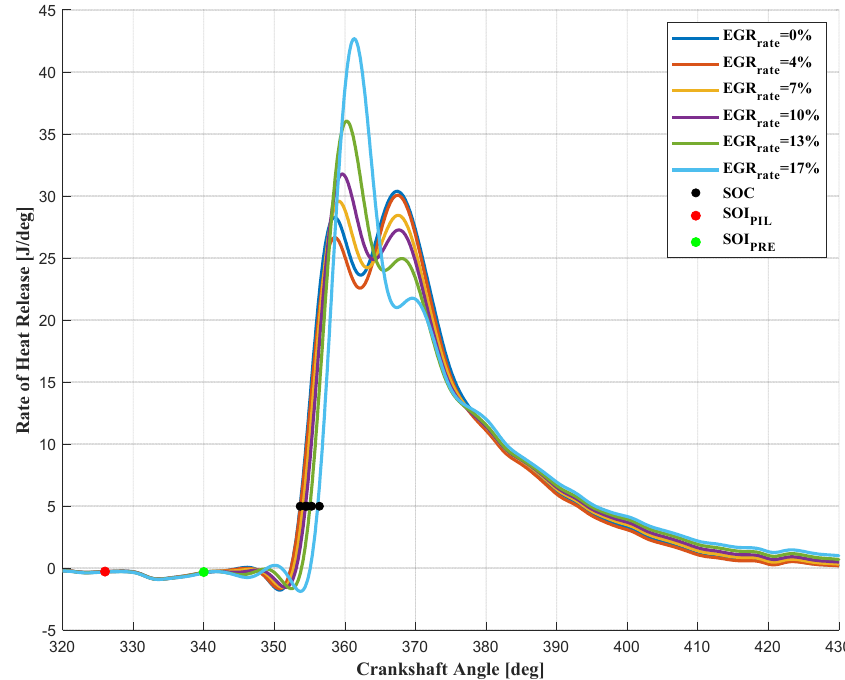
Figure 14. RoHR curves running GCI with different EGR rates.